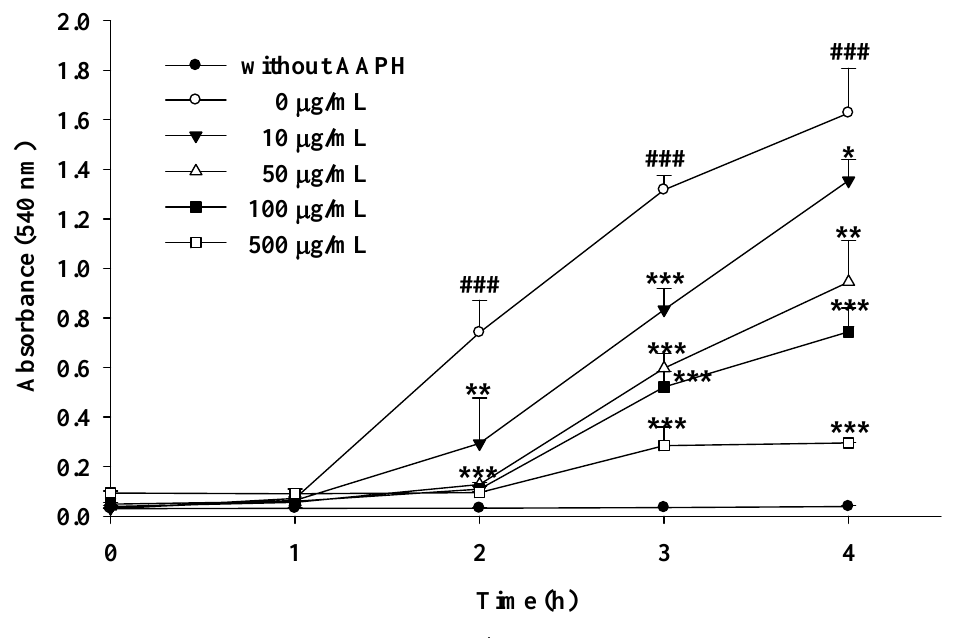
Figure 7. Inhibitory activity of IPE against AAPH-induced hemolysis of erythrocytes. (n = 4; significant difference versus control (without AAPH): ### , P < 0.001; significant difference versus control (without extract): * , P < 0.05; ** , P < 0.01; *** , P <